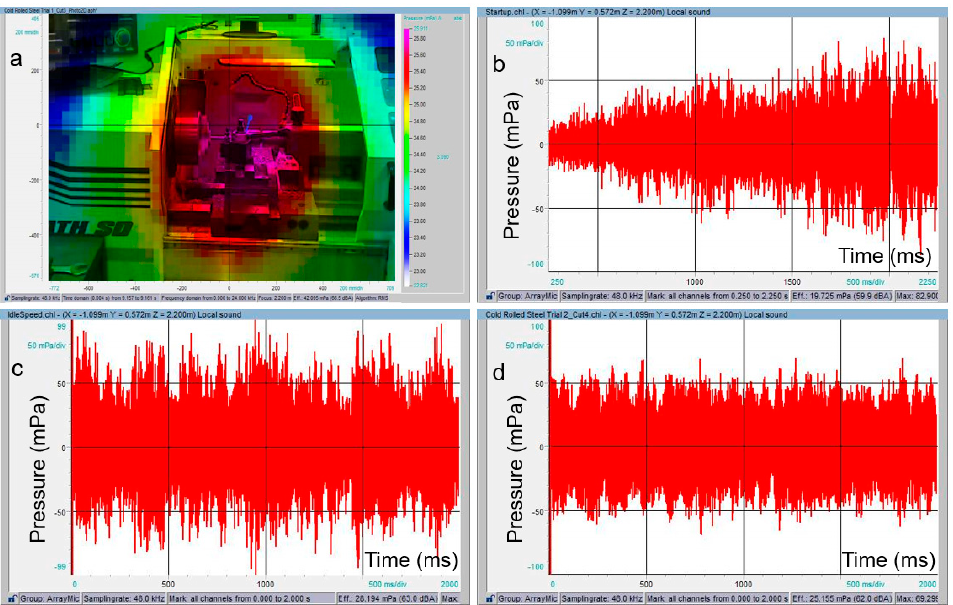
Figure 6. Acoustic emission for lathe machine: ( a ) 2D image superimposed with noise mapping intensity; ( b ) noise emission during startup; ( c ) noise emission during idle speed; and ( d ) noise emission during load.